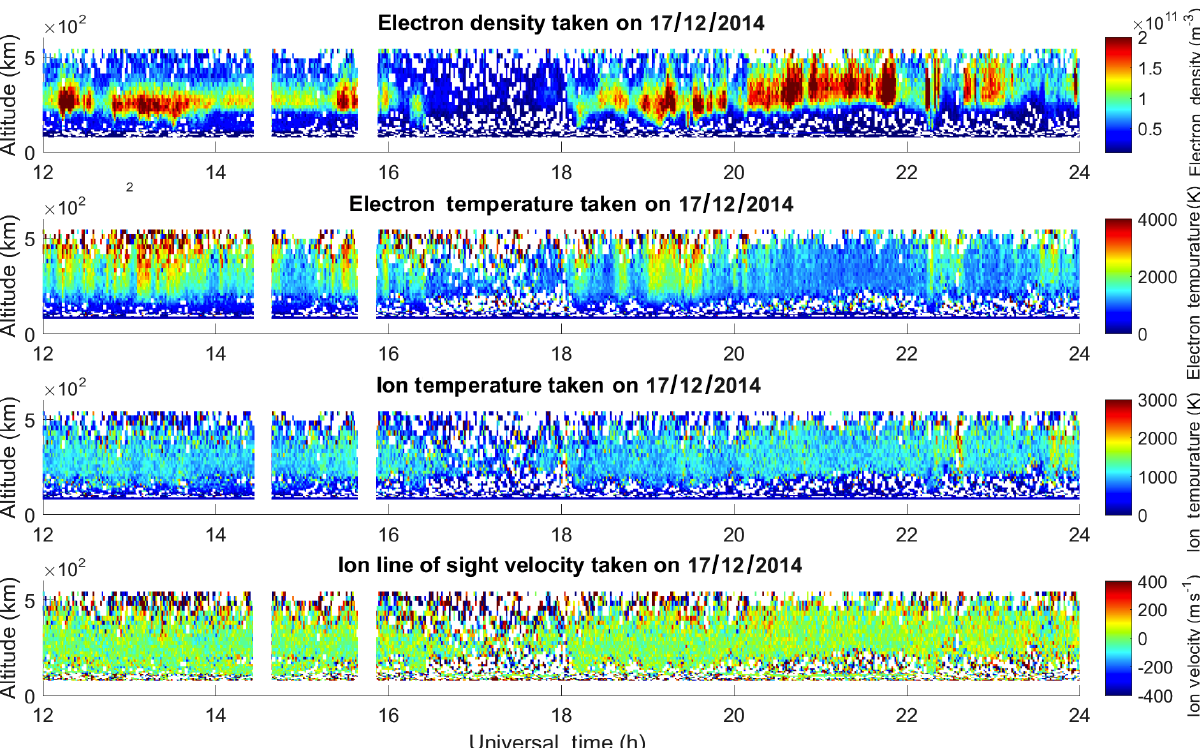
Figure 3. Electron densities, electron temperatures, ion temperatures, and ion drift line of sight velocity measured by the 42m dish of the ESR observing at an azimuth of 184.5 ◦ and an elevation of 81.6 ◦ between 12:00 and 23:59UT on 17 December 2014.